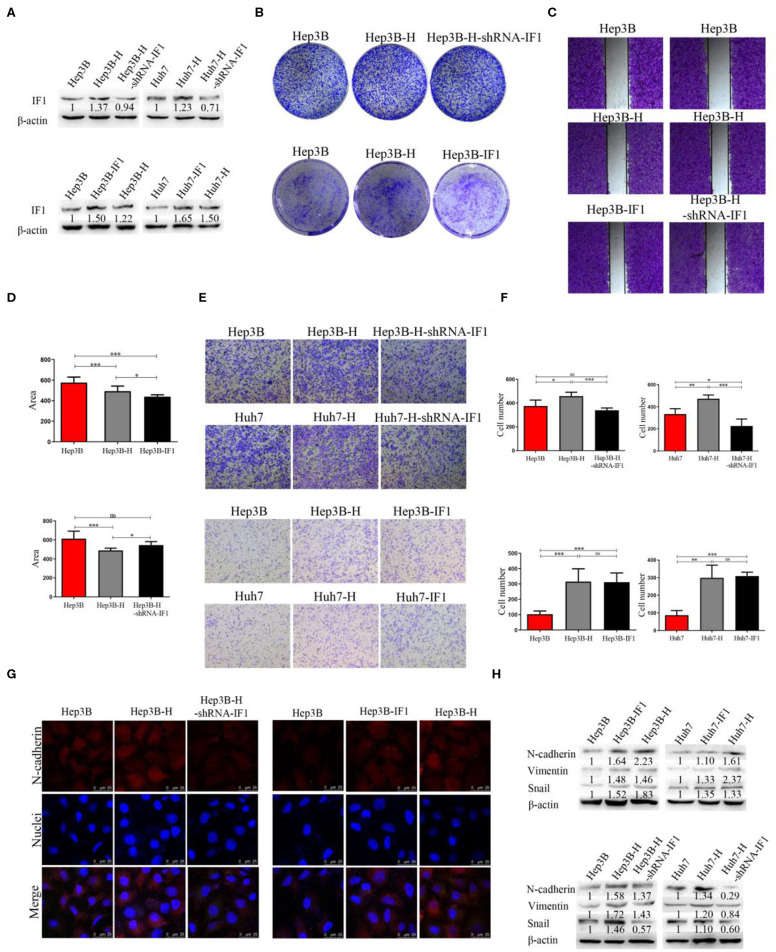
IF1 promoted EMT, cell proliferation, and migration in HCC cells after insufficient RFA. IF1 was overexpressed in Hep3B and Huh7 cells (Hep3B-IF1 and Huh7-IF1) and knocked down in Hep3B-H and Huh7-H cells (Hep3B-H-shRNA-IF1) and Huh7-H-shRNA-IF1. (A) Western blot validation of the transfection efficiency in Hep3B or Huh7 cells. (B) Colony formation assay analysis of cell proliferation after IF1 knockdown or overexpression in Hep3B cells after insufficient RFA. (C,D) Wound healing assay analysis of cell migration after IF1 knockdown or overexpression in Hep3B cells after insufficient RFA. (E,F) Transwell assay analysis of cell migration after IF1 knockdown or overexpression in HCC cells after insufficient RFA. (G) Immunofluorescence analysis of the N-cadherin and IF1 expression after IF1 knockdown or overexpression in Hep3B cells after insufficient RFA. (H) Western blot analysis of N-cadherin, snail, and Vimentin expression after IF1 knockdown or overexpression in HCC cells after insufficient RFA. Data are the means ± SD of at least three experiments. *P < 0.05, **P < 0.01, ***P < 0.001; ns, no significance.